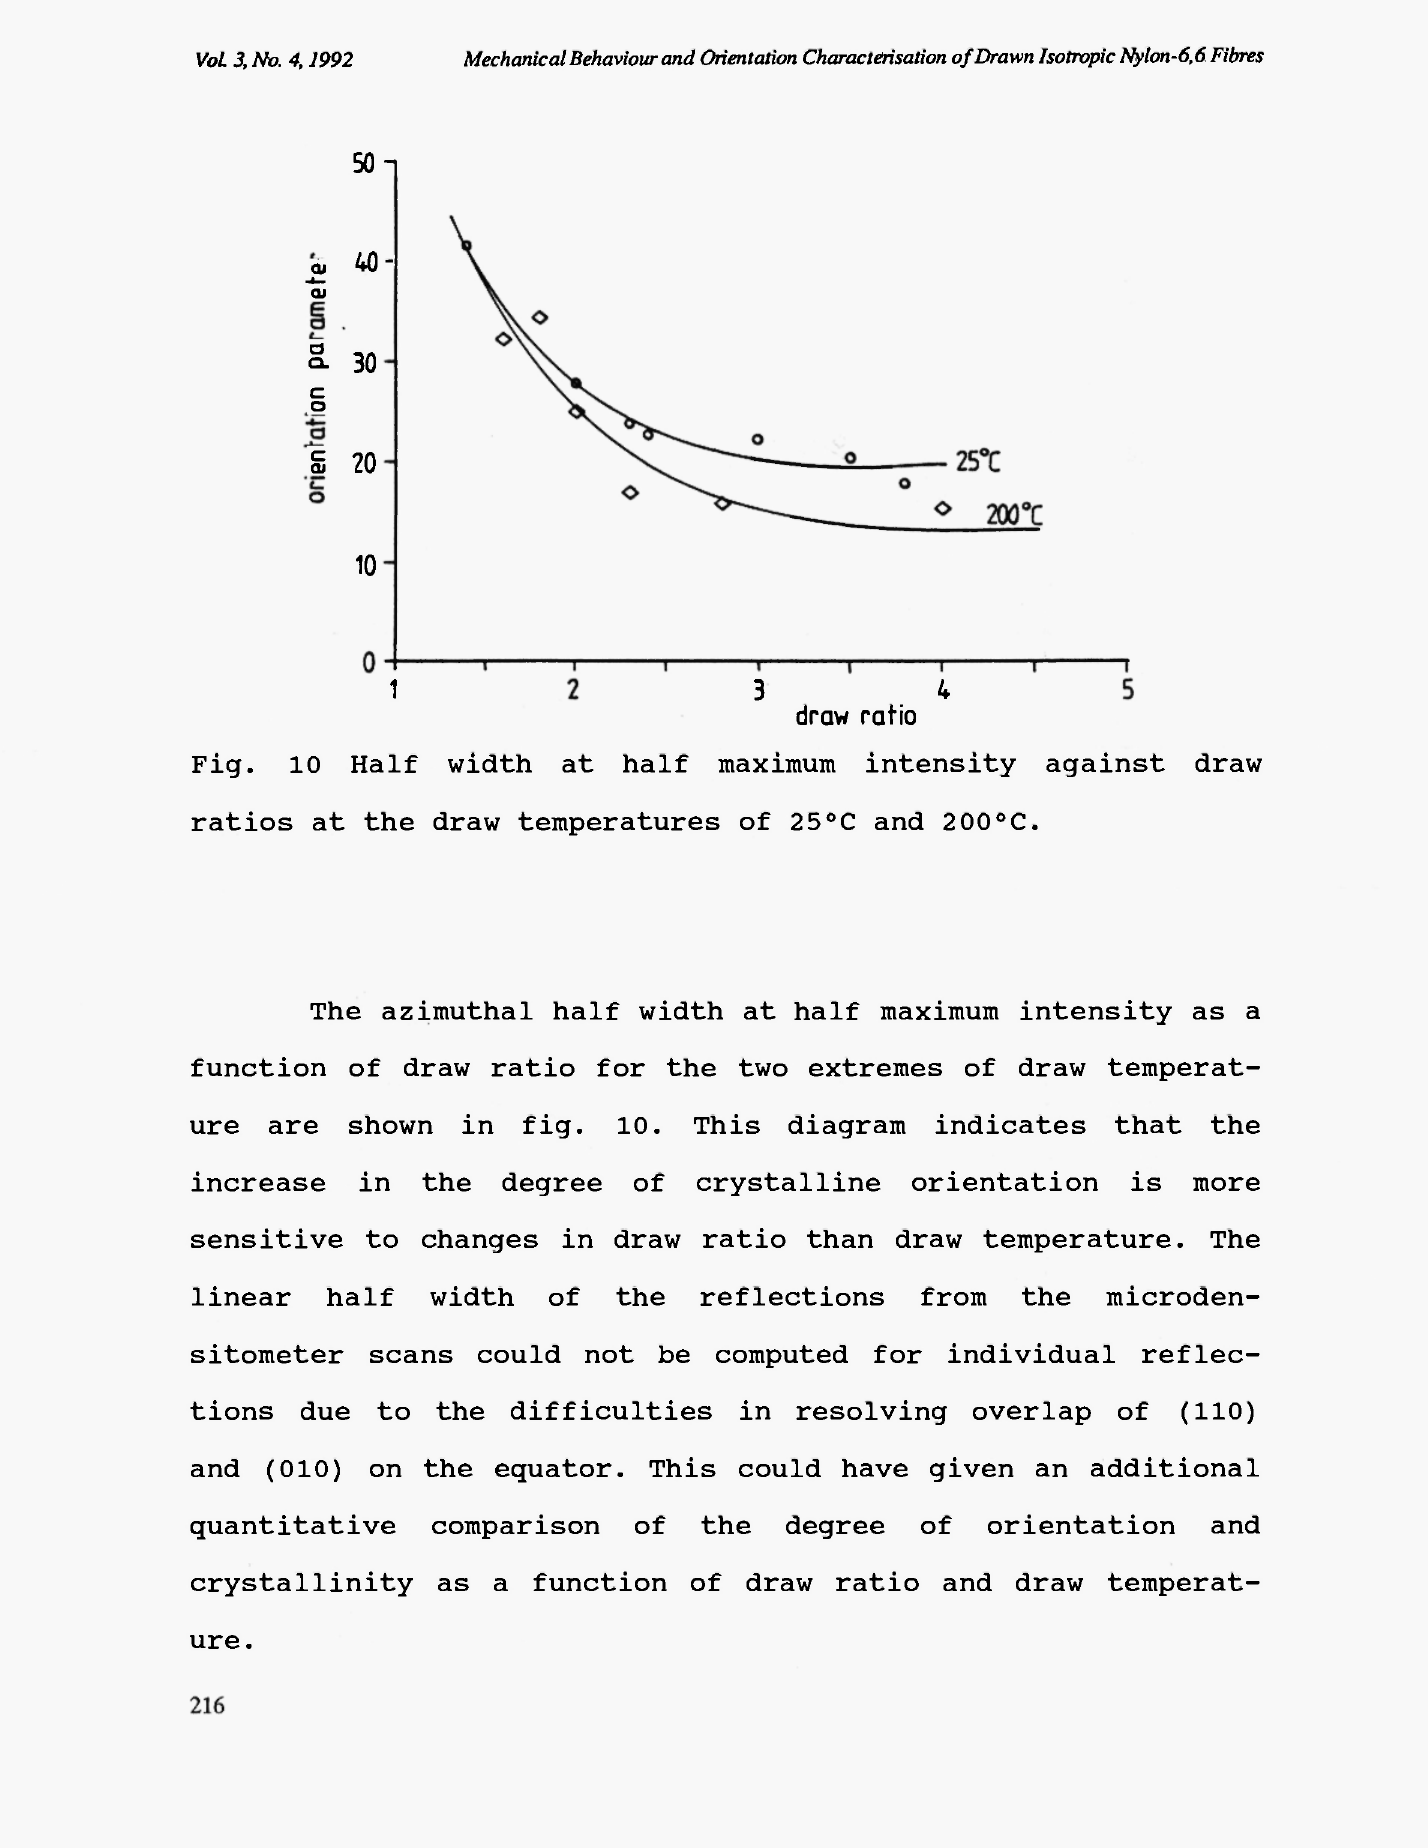
3 4 draw ratio Fig. 10 Half width at half maximum intensity against draw ratios at the draw temperatures of 25°C and 2 00°C.